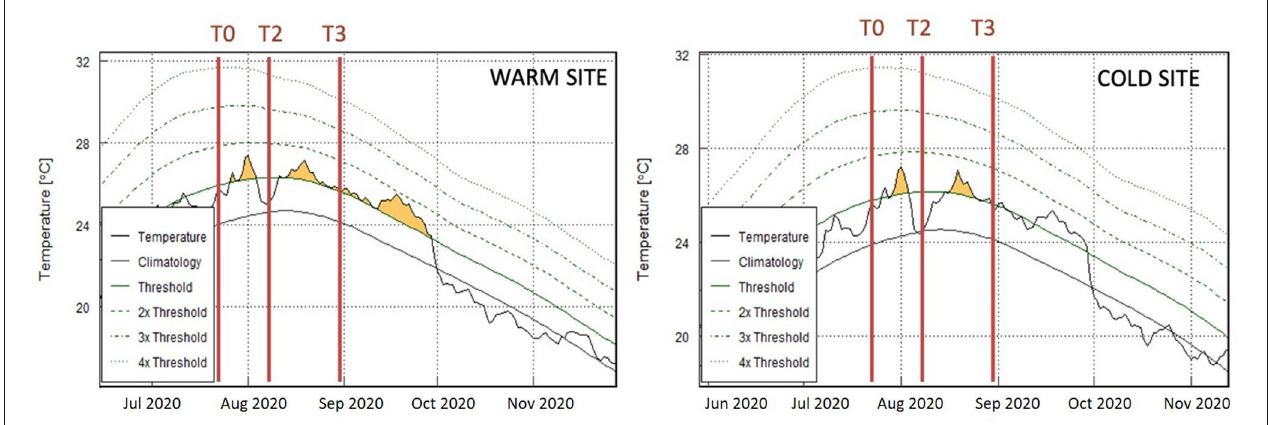
FIGURE 3 | Current MHWs. Summer 2020 MHWs at the warm and cold site. Red bars represent sampling times (T0, T2, and T3). Climatology was calculated based on the last 30 years of SST; Threshold represents the 90 th percentile of the climatology; 2x, 3x, 4x thresholds to define MHW categories (Hobday et al., 2016).